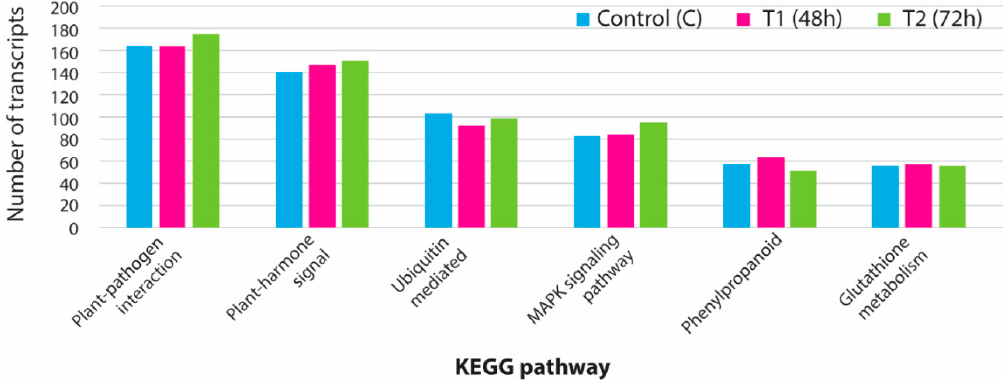
Figure 7. Total number of assembled transcripts associated with major pathways in plants mapped using Kyoto encyclopedia of genes and genomes database (KEGG). C: control; T1: 48 h PEG treatment; T2: 72 h PEG treatment.